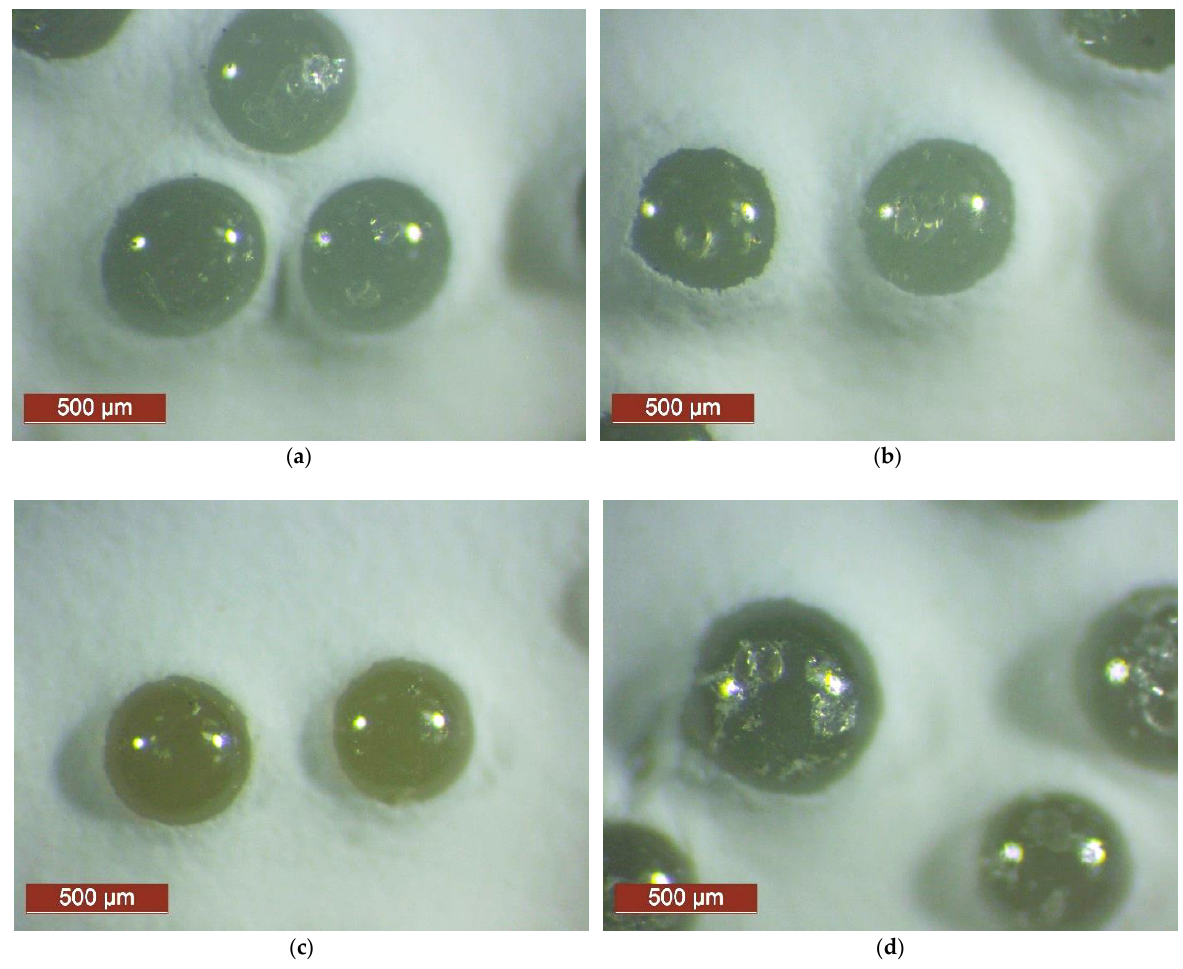
Figure 6. Microscope images (magnification 32×) of GB after exposure to 840 drum rotations with corundum: ( a ) standard (sample SF ), ( b ) large (sample ML ), ( c ) premium (sample SP ), ( d ) high index (sample HI ).